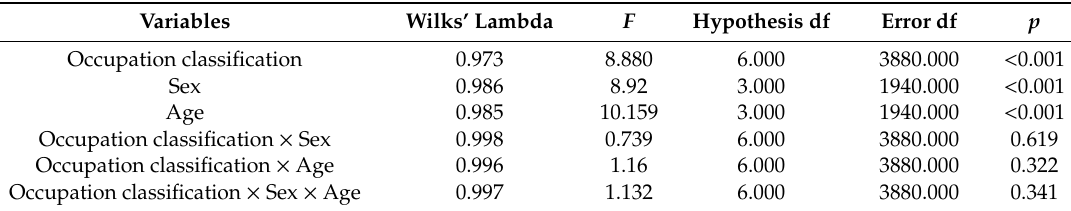
Table 2. Significance Tests of Multivariate Analysis of Variance Examining the Di ff erences in Risk Perception, Adoption of Protective Behaviors, and General Anxiety Across Various Occupation Classifications, Sex, and Age.